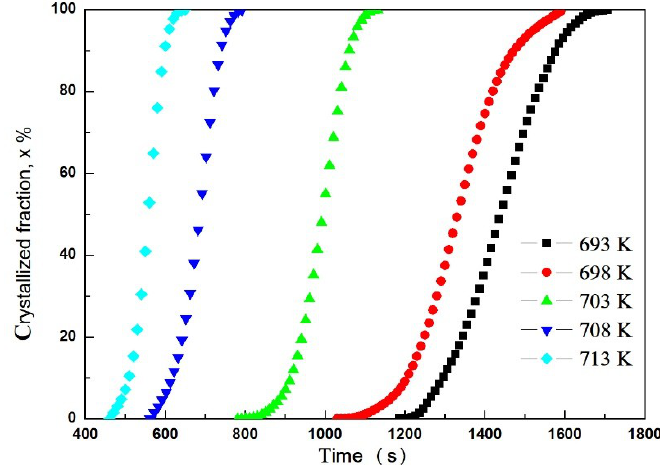
Figure 7. Time–temperature–transformation curves of the onset crystallization for the W particles/Zr 41.2 Ti 13.8 Cu 12.5 Ni 10 Be 22.5 metallic glass matrix composite.